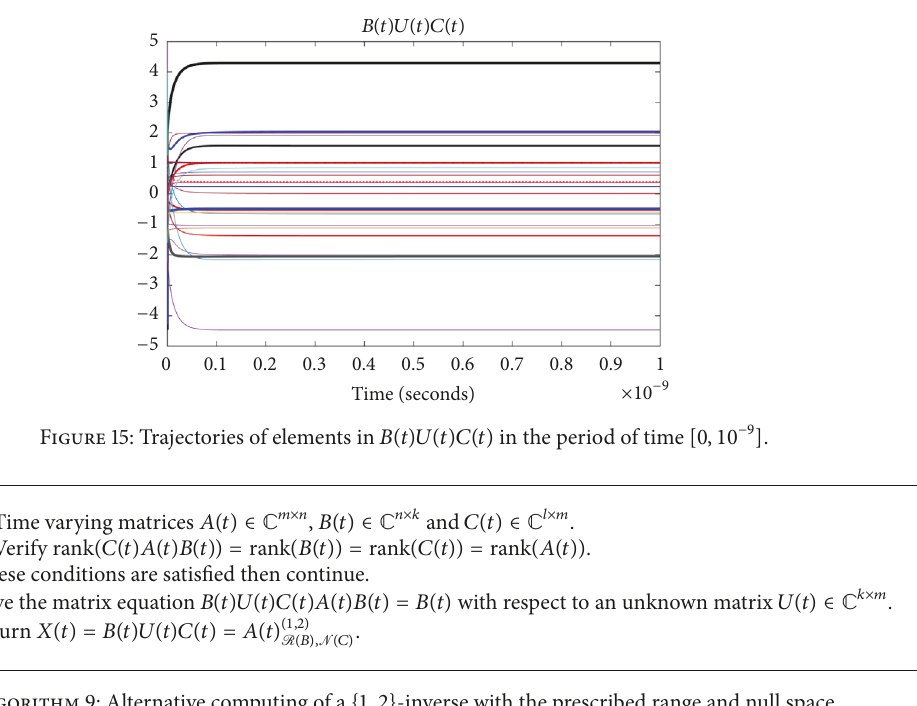
Algorithm 9: Alternative computing of a {1,2} -inverse with the prescribed range and null